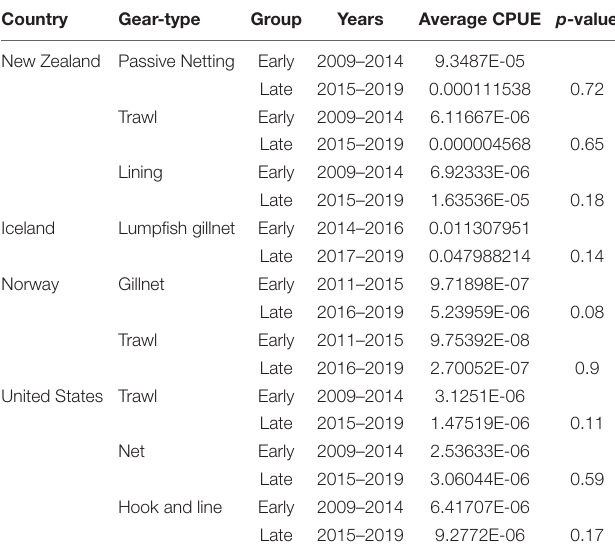
TABLE 4 | Average CPUE and p -value results of t -tests or Wilcoxon tests comparing fisher logbook CPUE over time for all gear types with sufficient data.